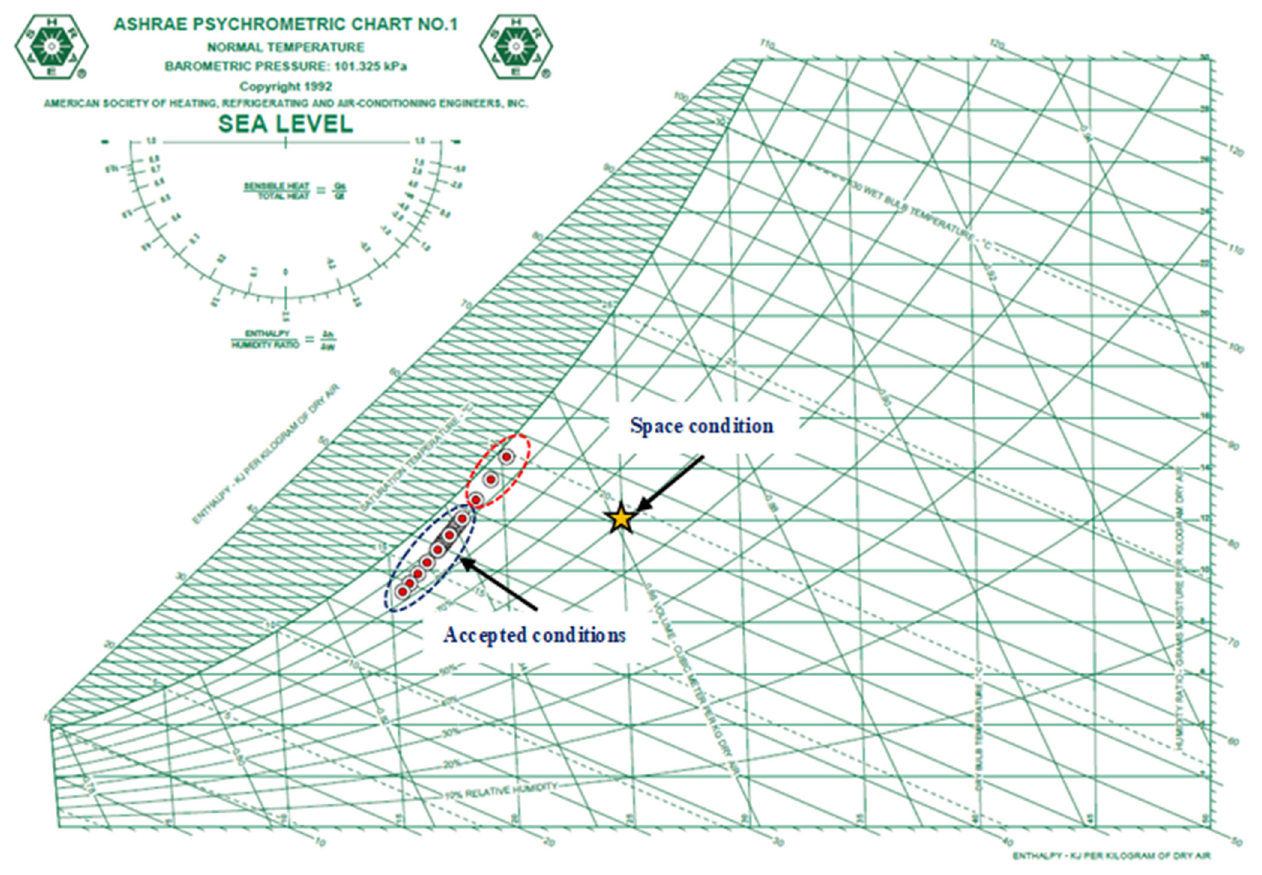
Figure 10. Accepted supply conditions to air-conditioned space (systems evaluation) for MGS-I and MGS-II.